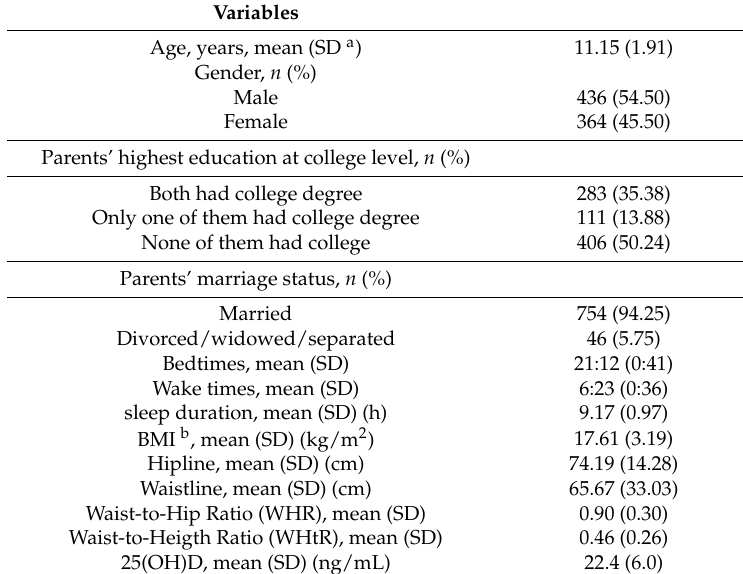
Table 1. Characteristics of the study subjects ( n =